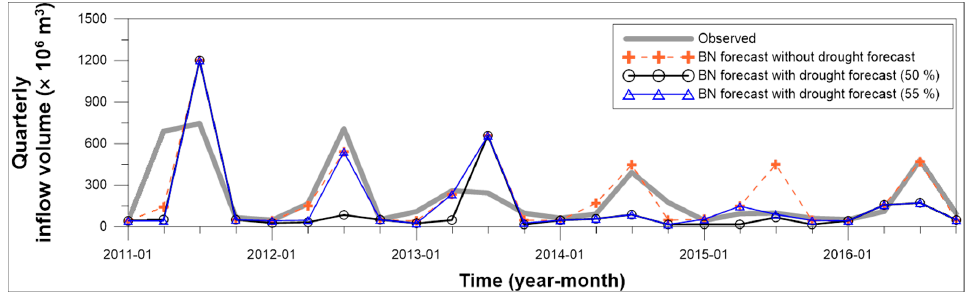
Figure 14. The results of quarterly inflow forecasting without or with drought forecast under the threshold probability of drought occurrence ranging 50–55% for the Andong dam. Table 5. Quarterly inflow forecasting errors for the Soyanggang dam.